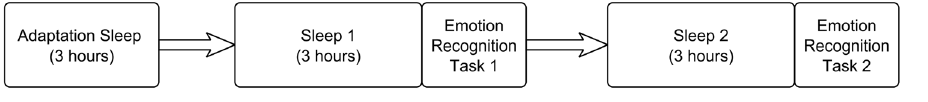
Figure 1. General